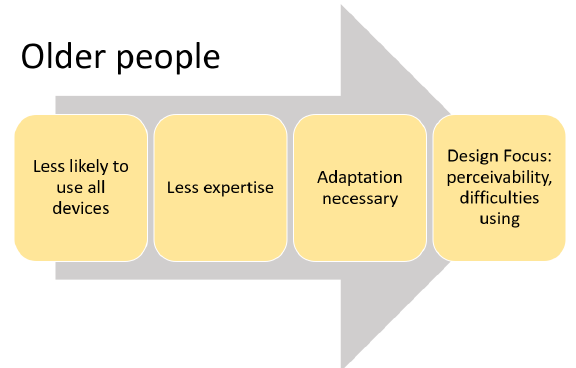
Figure 5. Overview of the opinions of computing students with regard to older